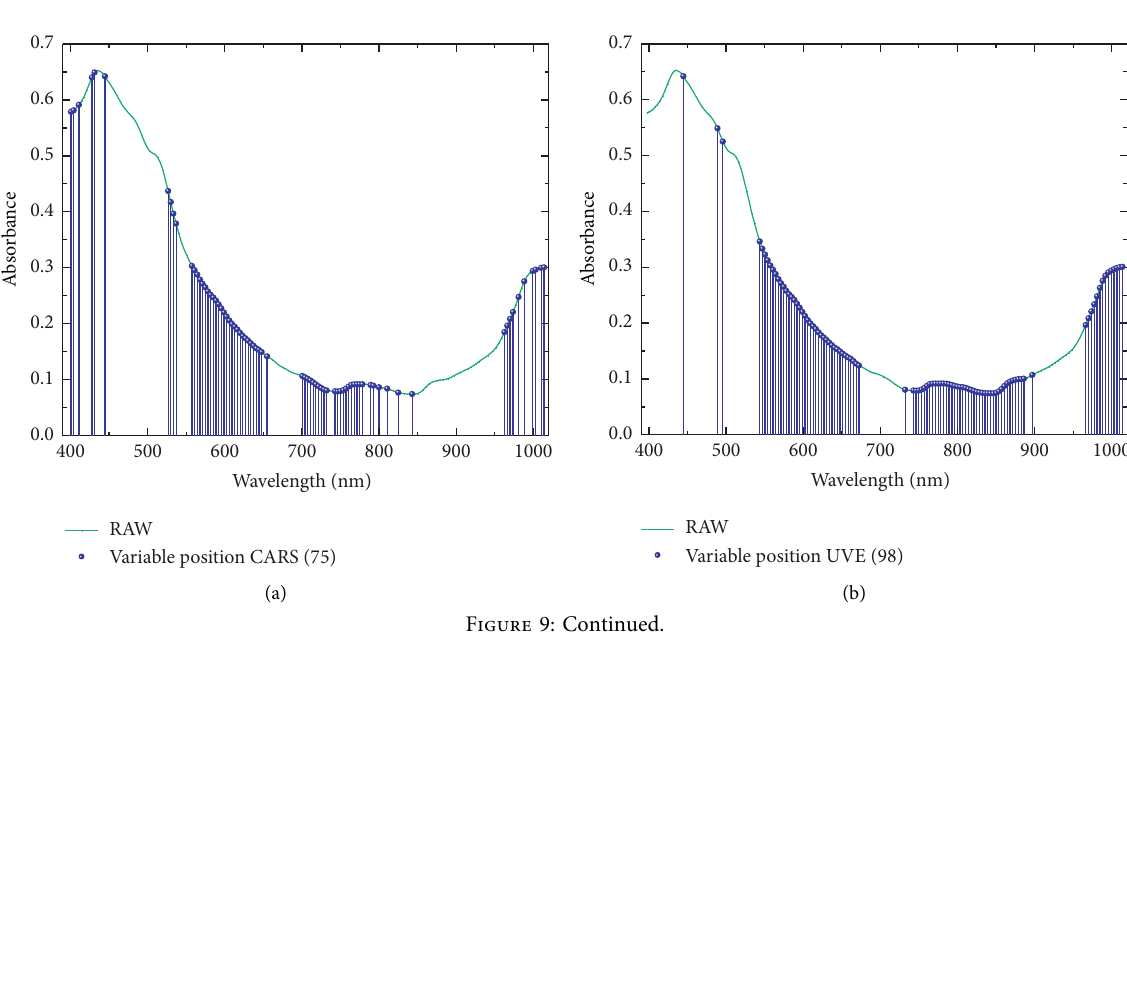
Figure 8: Results of R spectra characteristic wavelength selection based on CARS and UVE. Characteristic wavelength of R-RAW spectra selected based on (a) CARS and (b) UVE. Characteristic wavelength of R-GF spectra selected based on (c) CARS and (d) UVE. Characteristic wavelength of R-COW spectra selected based on (e) CARS and (f)